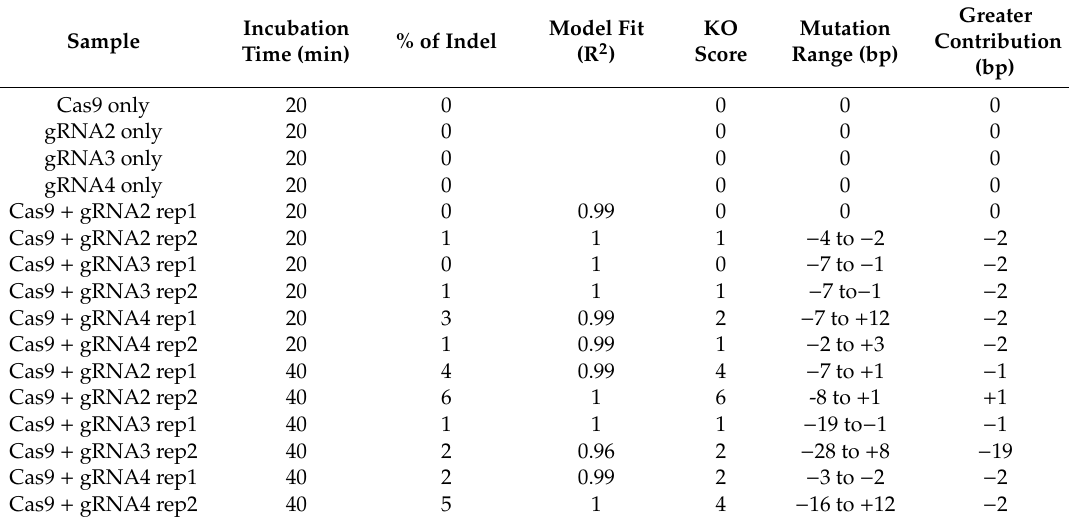
Figure 5. Sequence distribution of most efficient mutations identified with the ICE software around the IPK gene target site in Zea mays . Edited sequences were obtained after CRISPR-Cas9 RNP transfection to maize protoplasts. Forty-five μ g of Cas9 preassembled with 15 μ g of each gRNA were used in the protoplast transformation. Different exposure times of the RNP complex with the protoplast are presented. Cut sites are represented by black vertical dotted lines, insertions are represented by ‘N’ and deletions by black horizontal dotted lines.